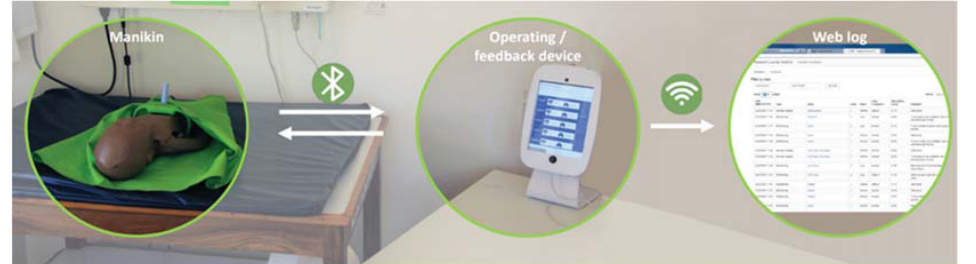
Figure 2. NeoNatalie Live including the manikin, operating/feedback tablet device (app), and web log. Photo by Laerdal Medical. log. Photo by Laerdal